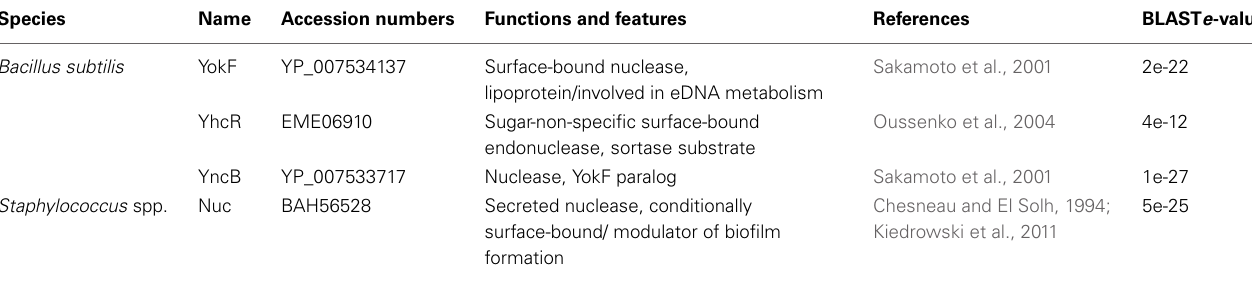
Table 2 | Hvo_1477 protein homologs with known functions. Species